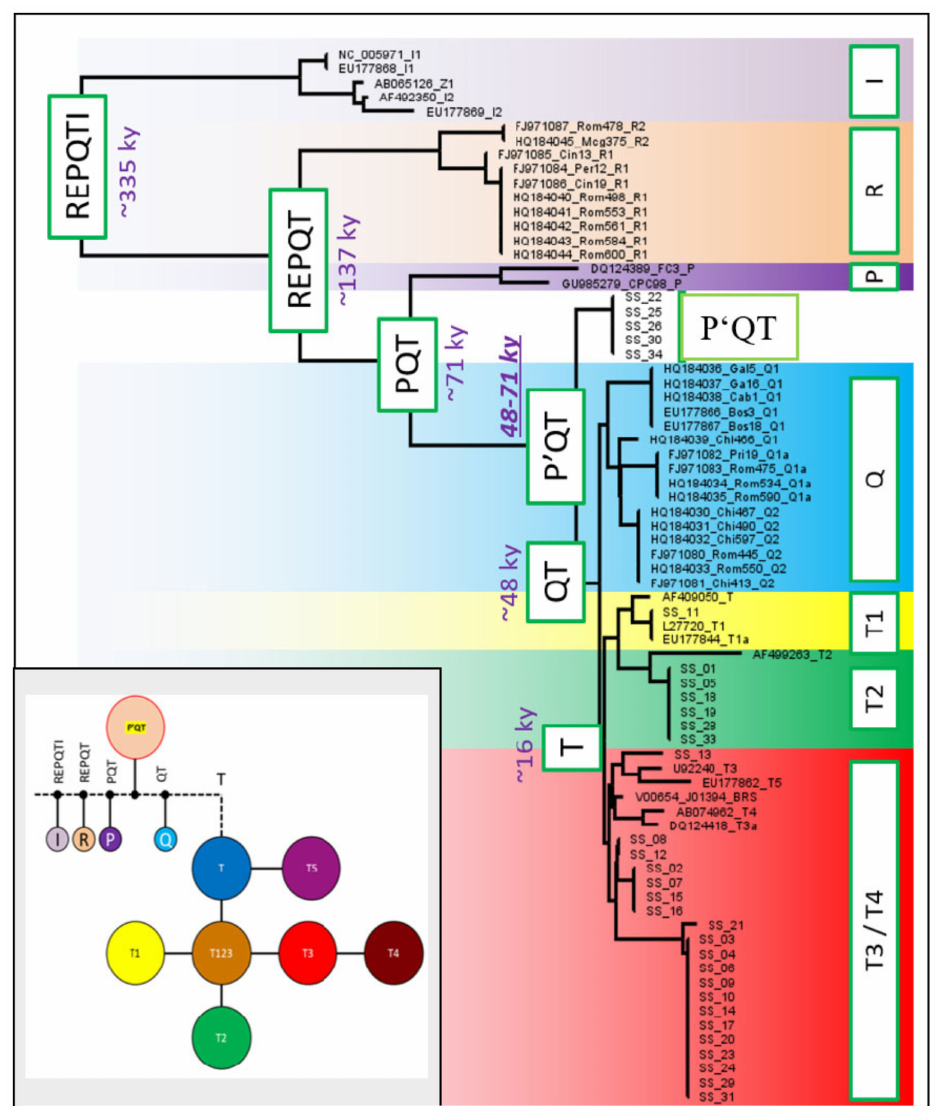
Figure 9. Phylogenetic tree obtained from the data analysis of the cytochrome b gene and the estimation of divergence